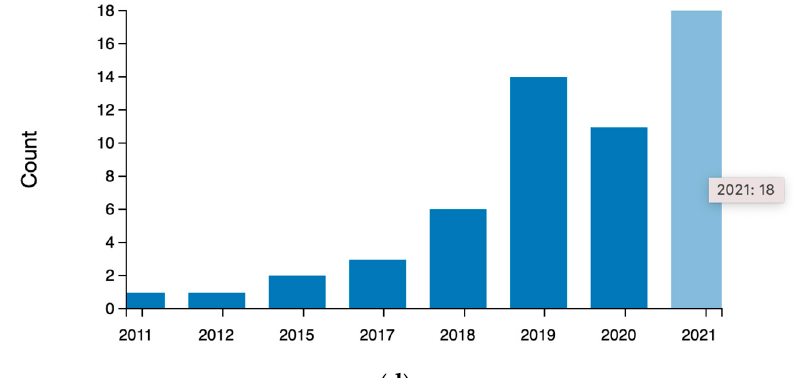
Figure 1. Geospatial distribution and simple statistics of the reviewed papers. Note that a freely accessible interactive version of the charts can be accessed via our web app tool (the web app tool URL and its brief demo video are provided in Appendix A). We can easily see that the major countries are China and the United States and that the number of published papers by year (2011 to 2021) has dramatically increased since 2018 and 2019. ( a ) Spatial distribution of reviewed papers based on the first author’s institution location. ( b ) Topic distribution (water body, water quality, both). ( c ) Country distribution. ( d ) Number of published papers by year from 2011 to 2021 on the relevant topics.